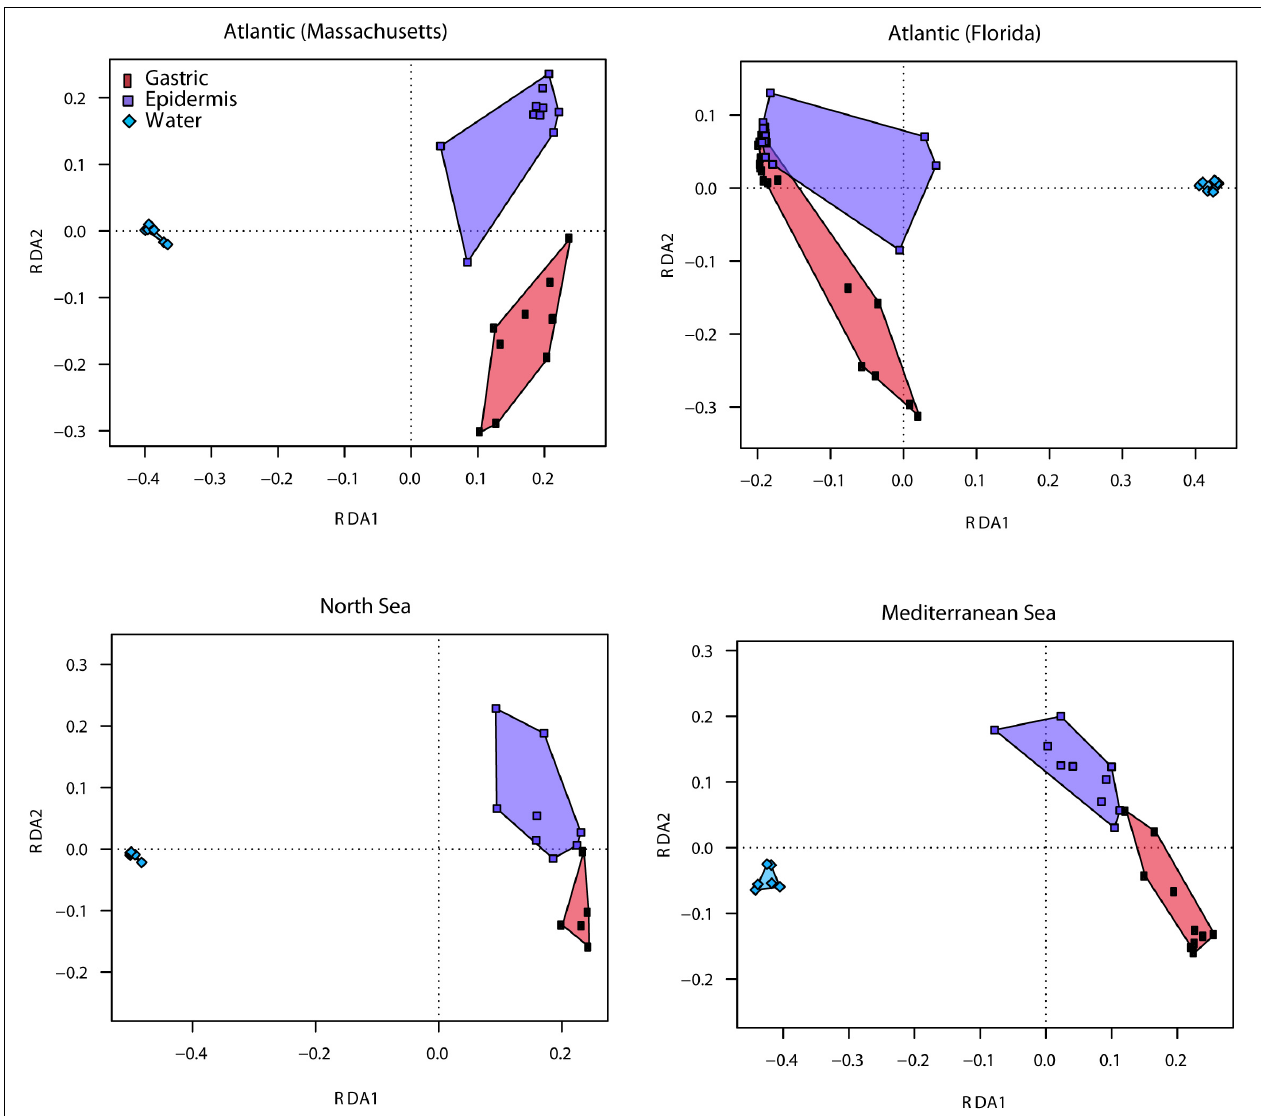
FIGURE 2 | Redundancy analysis (RDA) models of Hellinger-transformed OTU abundances comparing Mnemiopsis leidyi associated bacteria of the gastric cavity and epidermis with the respective ambient water. Graphical representation (distance plots) of RDA model of Hellinger-transformed OTU abundances. Each point represents the whole microbiota community of an individual sample from gastric cavity, epidermis, and ambient seawater of the respective sub-population. Groups of related sample points are framed by polygons filled with a corresponding color to elucidate distribution and variability of sample groups in the ordination space.